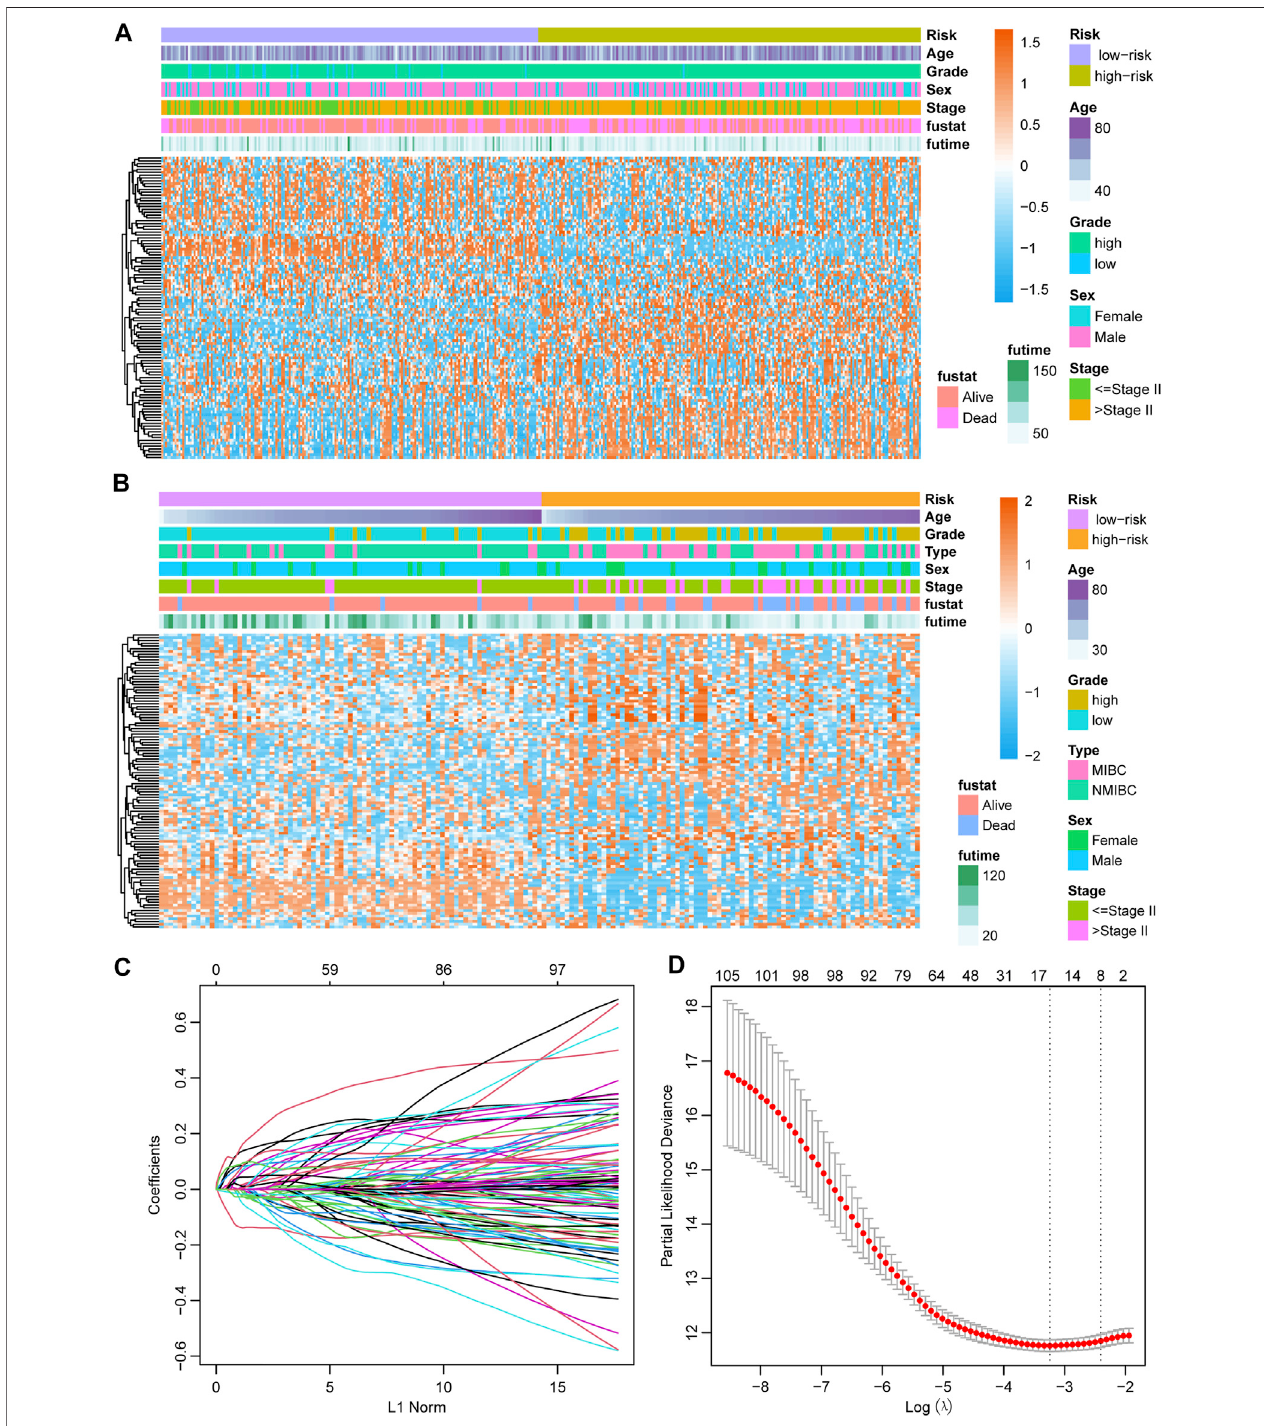
FIGURE4| Establishmentoftheprognosticmodel (A) Heatmapshowingtheexpressionof107candidategenesintheTCGA-BLCAcohort. (B) Heatmapshowing the expression of 107 candidate genes in the GSE13507 cohort. (C) The optimal tuning parameter (lambda) in the LASSO analysis selected with 5-fold cross-validation and one standard error rule. (D) LASSO coef fi cient pro fi les of the 107 candidate genes.